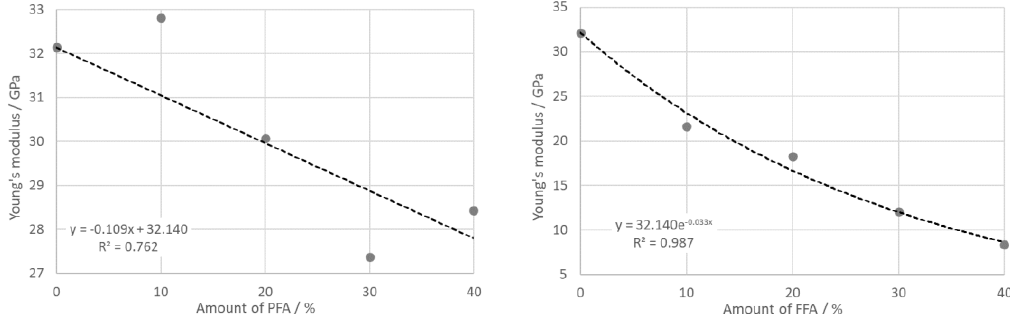
Figure 10. Young’s modulus of PF ( left ) and FF ( right ) samples (measured at the room temperature after firing at 1100 °C).